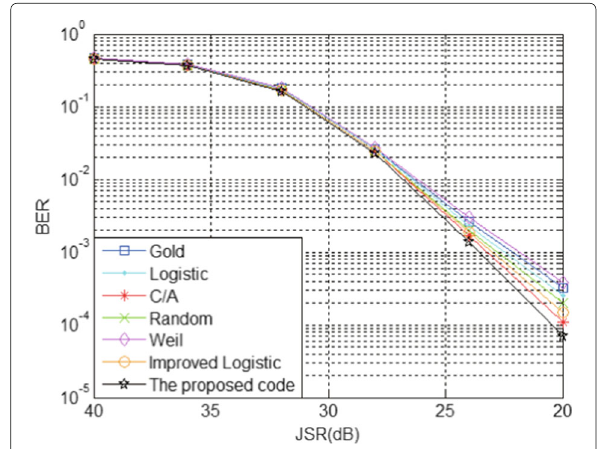
Fig. 9 BER curve of ranging codes with JSR under noise AM jamming